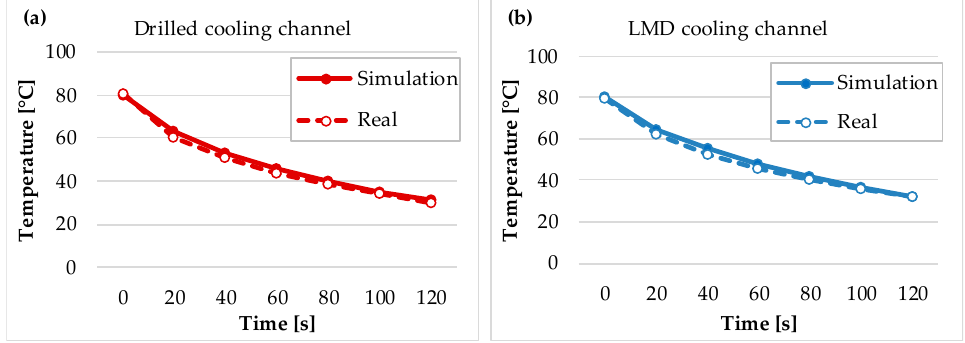
Figure 9. Simulation and real results for ( a ) drilled; ( b ) LMD cooling channels.